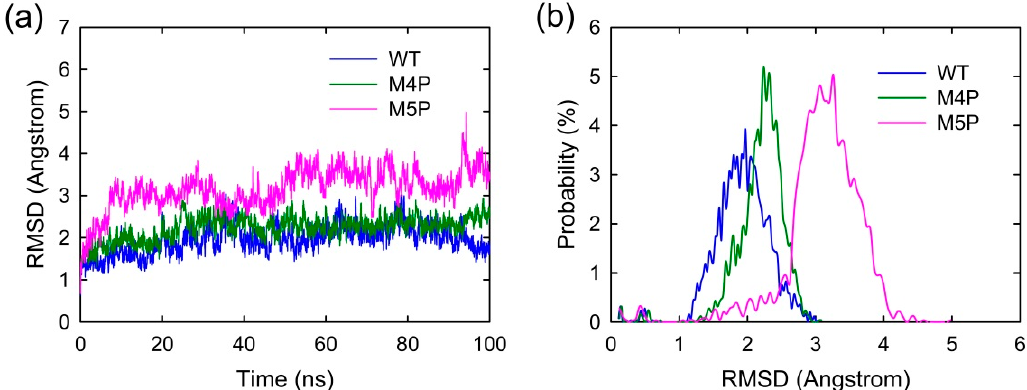
Figure 2. ( a ) RMSD evolutions of protein C α atoms with simulation time in WT, M4P and M5P systems; ( b ) Probability distribution of RMSD values.